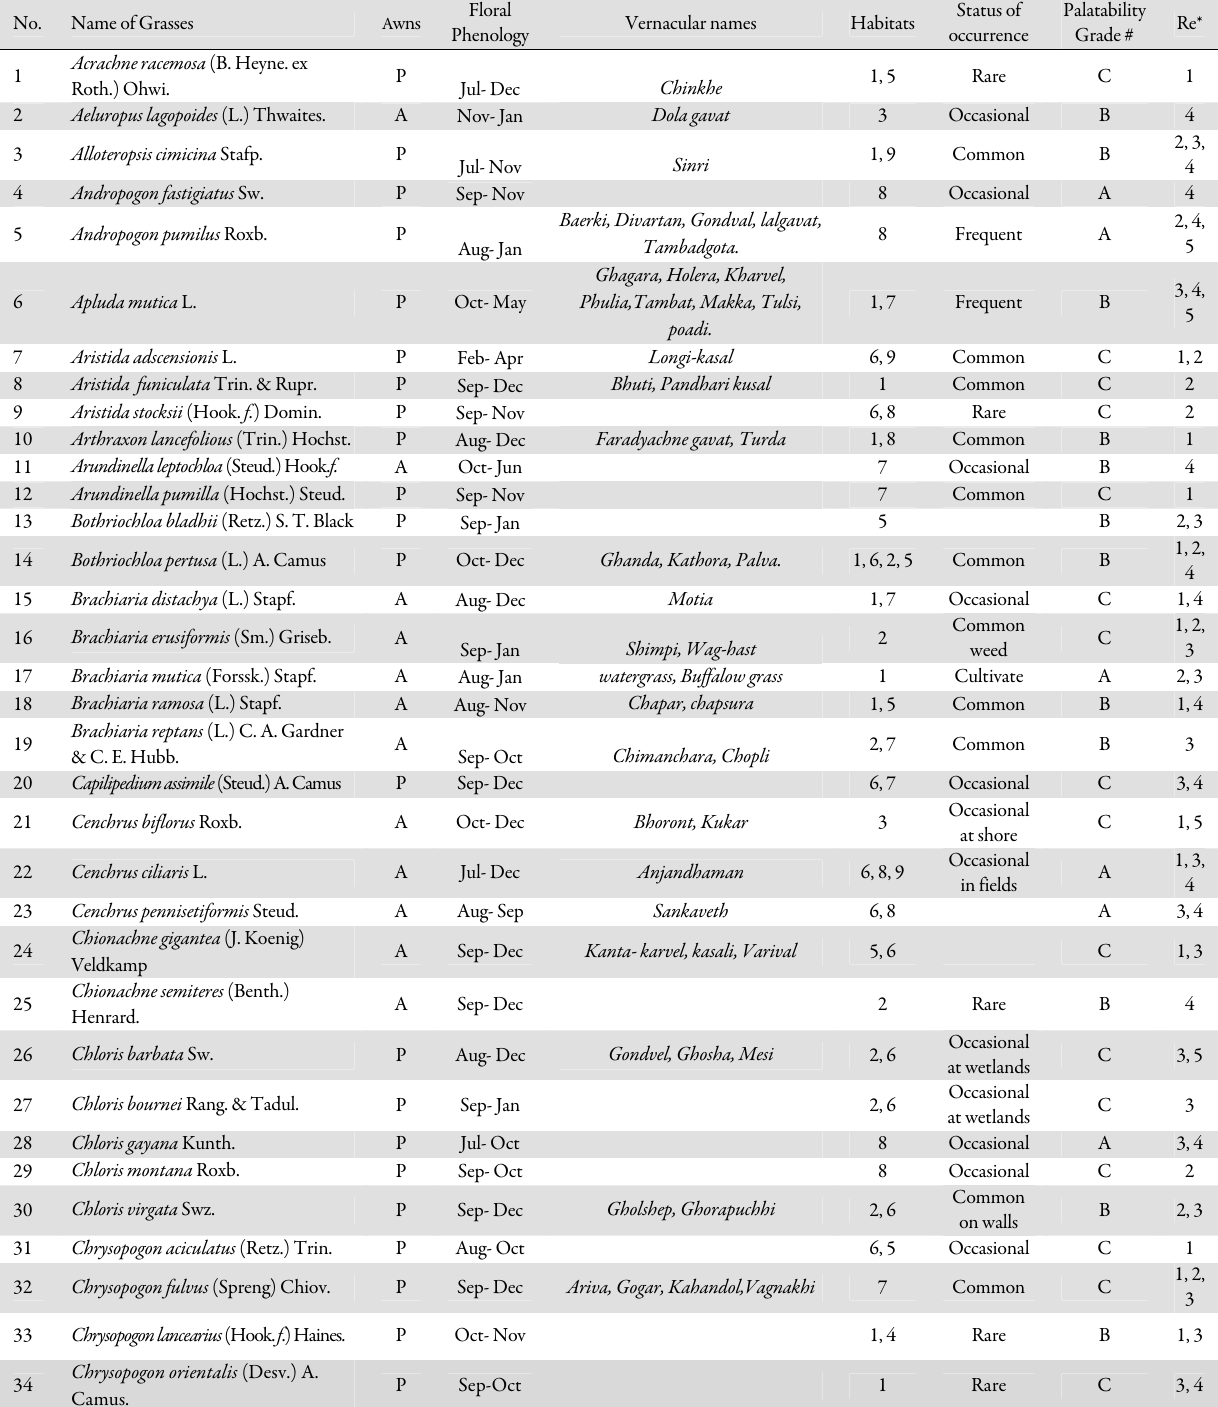
Tab. 3. Checklist of palatable grass species from Peninsular India with details like Presence or Absence of awns, Floral phenology, Vernacular names, Habitat, Palatability grade, References and Botanical names as per recent